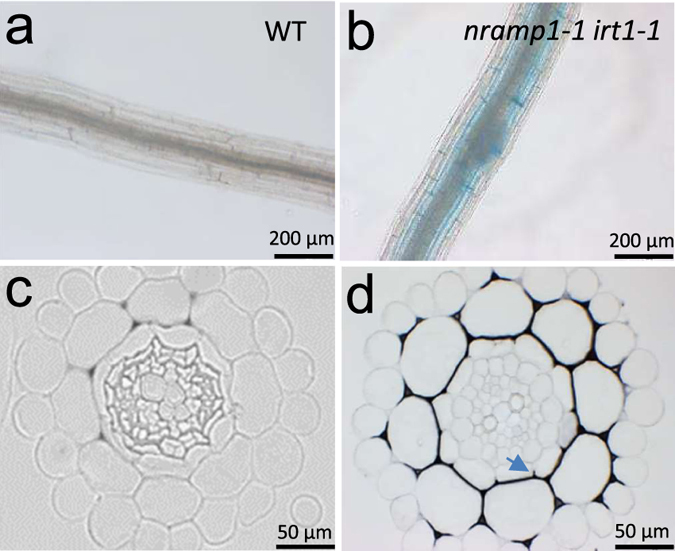
Fe accumulates in the apoplastic space of nramp1-1 irt1-1 roots.(a) and (b) Perls staining of entire roots from 15 day-old wild type (WT) and nramp1-1 irt1-1 seedlings grown in vitro in standard conditions. (c) and (d) Perls-DAB staining of thin root sections of WT and nramp1-1 irt1-1 seedlings grown as in (a) A blue arrow in panel (d) highlights the interruption of the Perls-DAB labelling by the casparian strip.